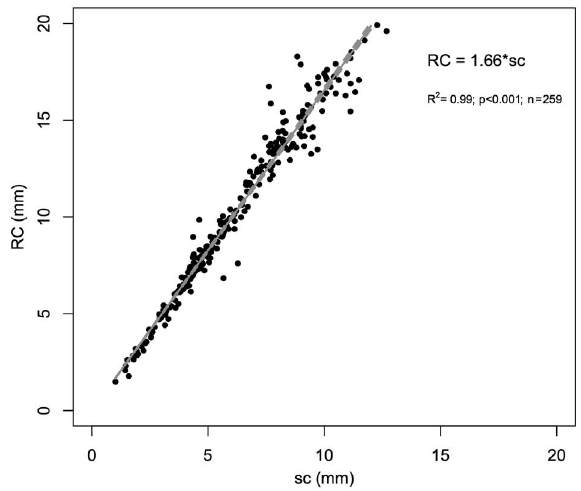
Fig. 2. – Relationship between maximum rostro-carinal length Fig. 3. – P. pollicipes monthly growth (dRC30) variation with (RC) and maximum scutum length (sc) in P. pollicipes from Cabo initial barnacle size (RC_i). Generalized Additive Model (GAM) Sardão (Portugal). Linear regression model prediction for the mean predictions for mean (solid black line) and 95% confidence intervals response value (solid grey line) is shown superimposed on the ob- (dashed black lines) are superimposed on the observed data for low- served data (black dots). and high-shore levels (black and grey dots, respectively).